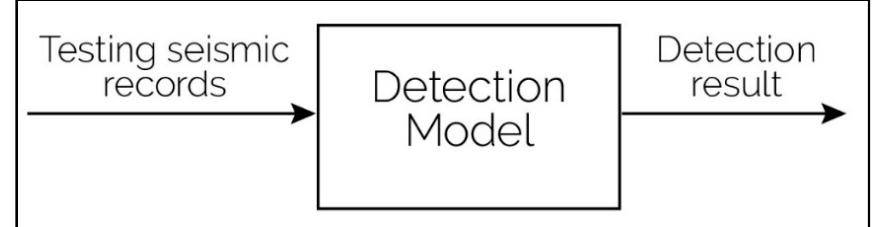
Figure 7. Classification model.